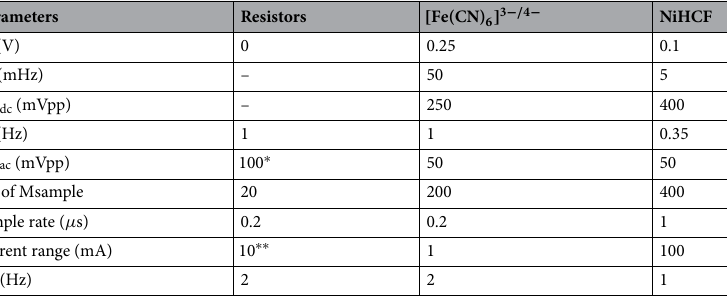
Table 2. Summary of DMFA parameters used in the acquisition of dynamic impedance. *The amplitude of the multisine was scaled with the measured resistors to avoid errors due to current-voltage amplification. 100 mVpp was used for the equivalent resistor ( R m ) of the current range and the amplitude used for other resistors was scaled by the ratio of the resistor to R m of the current range. **A current range of 1 mA was also used to investigate the effect of selecting an inappropriate current